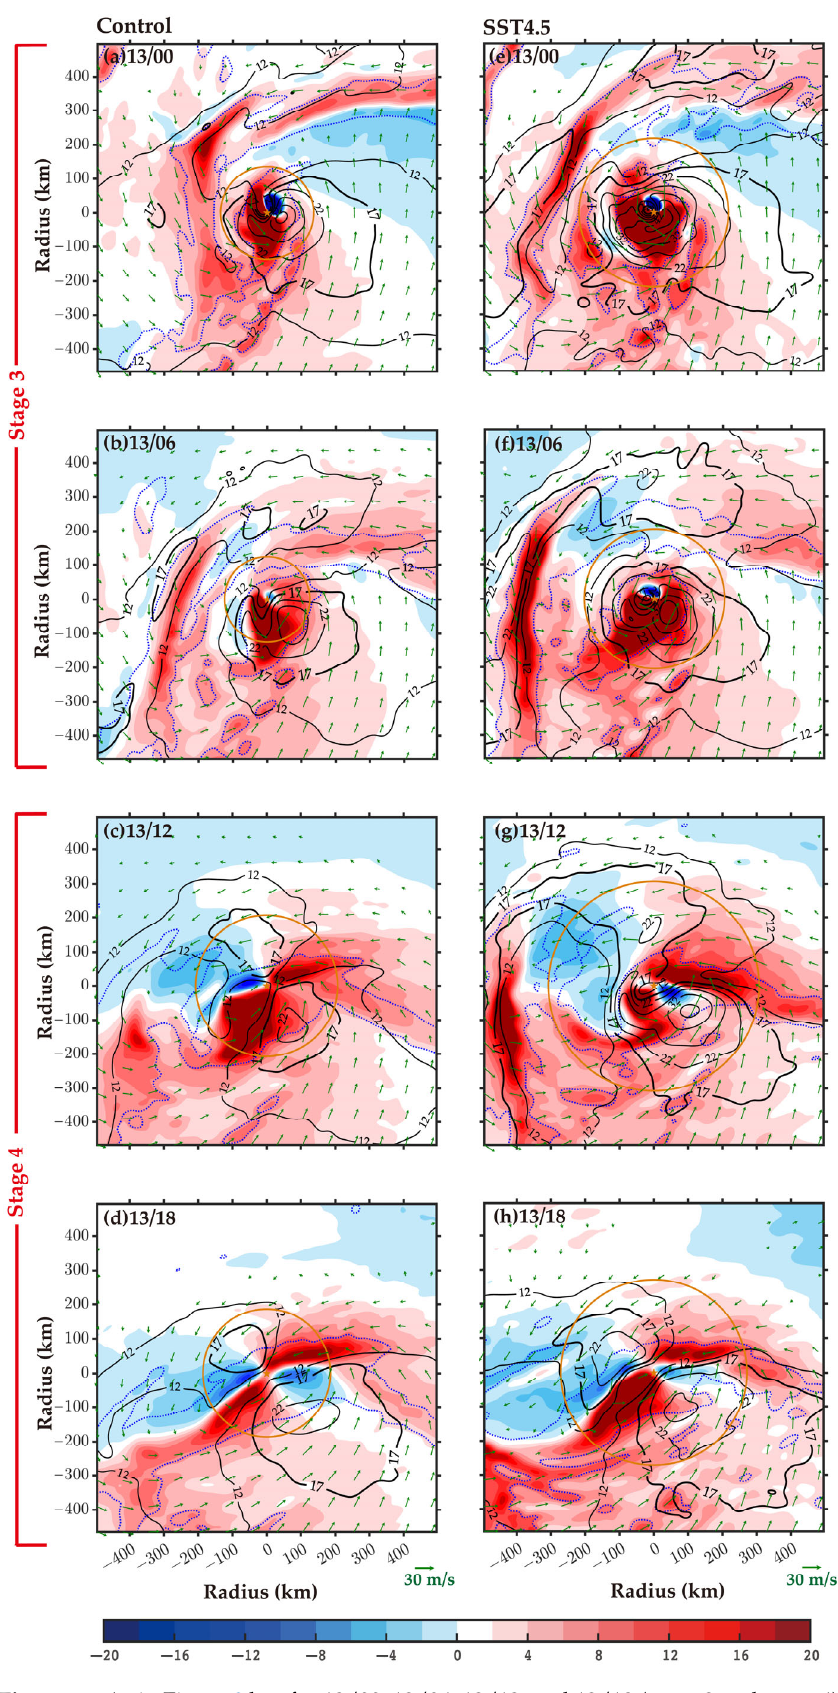
Figure 13. As in Figure 9 but for 13/00, 13/06, 13/12, and 13/18 (stage 3 and stage 4).